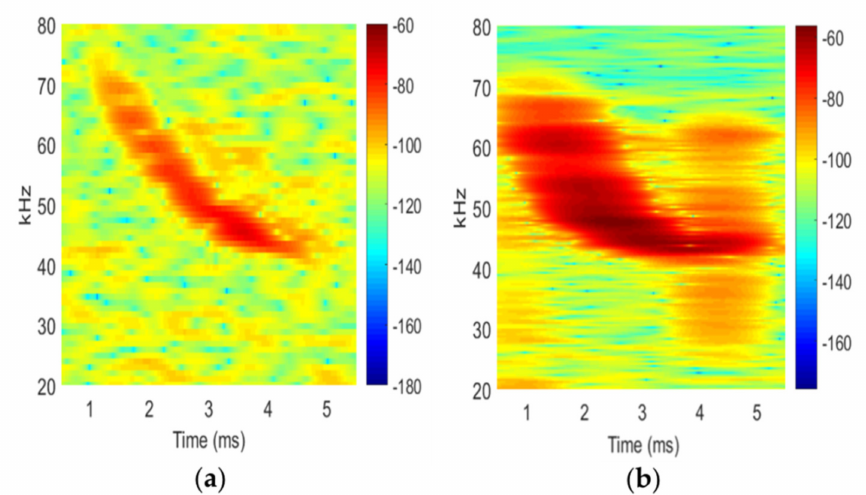
Figure 2. ( a ) Spectrogram of the recorded eastern red bat ( Lasiurus borealis ) call from the field used to create the synthetic call. ( b ) Spectrogram of the synthetic SonicBeagle call as recorded on a Wildlife Acoustics SM2BAT+ (right) that was used in the anechoic chamber experiments, Blacksburg, VA, USA 2016. The color scale represents amplitude in decibels with blue corresponding to lower amplitude and red corresponding to higher amplitude. The y -axis represents frequency in kHz and the x -axis represents time in milliseconds